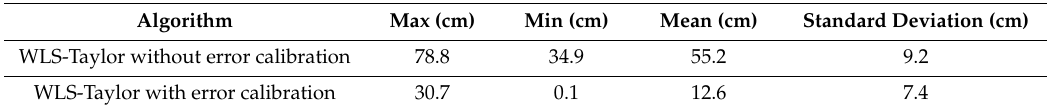
Table 2. Experimental result table of error calibration